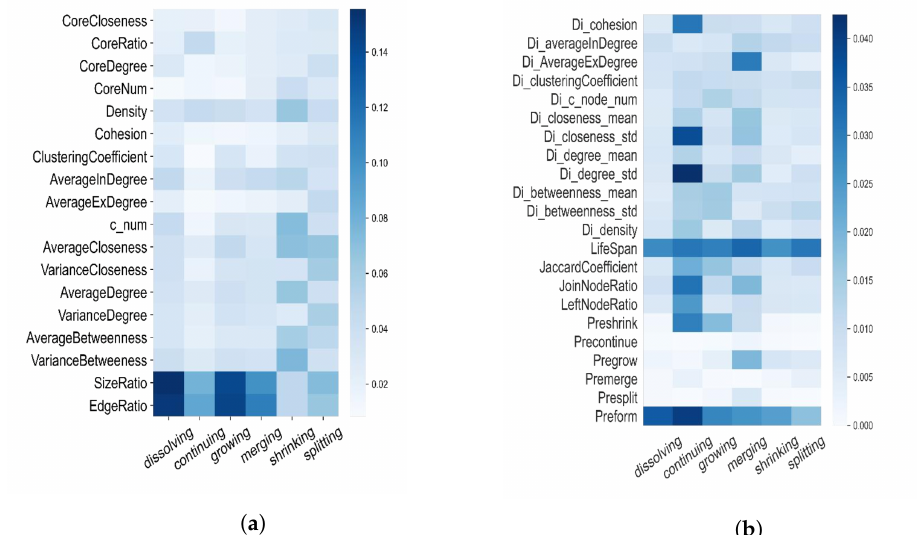
Figure 2. Distribution of the importance of each feature in the Hepth data set: ( a ) Core node features and Community structural features; ( b ) Community sequential features and Community behavior features.